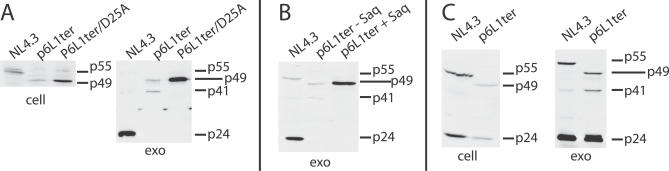
HIV Virus Can Bud from Cells Independently of Its p6 Domain(A) Anti-HIV Gag immunoblots of cell (cell) and exosome (exo) lysates (constant exosome:cell ratio) of 293T cells transfected with equal amounts of (left lanes) pNL4.3ΔEnv::GFPkdel, (middle lanes) pNL4.3ΔEnv::GFPkdel/p6L1ter, and (right lanes) pNL4.3ΔEnv::GFPkdel/p6L1ter/PRD25A.(B) Anti-HIV Gag immunoblots of exosomes secreted by 293T cells transfected with equal amounts of (left lane) pNL4.3ΔEnv::GFPkdel or (middle and right lanes) pNL4.3ΔEnv::GFPkdel/p6L1ter , incubated in the (middle lane) absence or (right lane) presence of 7.5-μm HIV protease inhibitor.(C) Anti-HIV Gag immunoblots of cell and exosome lysates from Jurkat T cells transfected with equal amounts of (left lanes) pNL4.3ΔEnv::GFPkdel and (right lanes) pNL4.3ΔEnv::GFPkdel/p6L1ter.